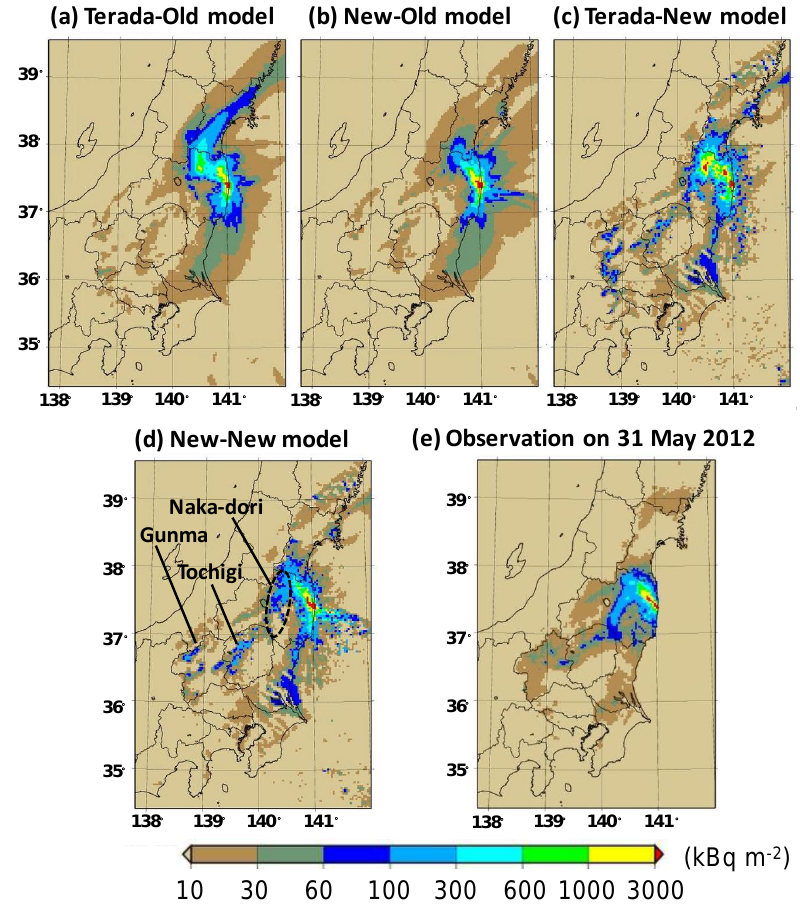
Figure 13. Spatial distributions of surface deposition of 137 Cs over eastern Japan (Domain 2) in (a–d) the four simulations using original and modified WSPEEDI-II (referred as “Old model” and “New model”, respectively) and Terada at al. (2012) and the new source terms (referred as “Terada” and “New”, respectively) and (e) observations (NRA, 2012a) and at 00:00 on 1 April 2011. The dashed ellipse in (d) represents the Nakadori area in Fukushima Prefecture (Sect.